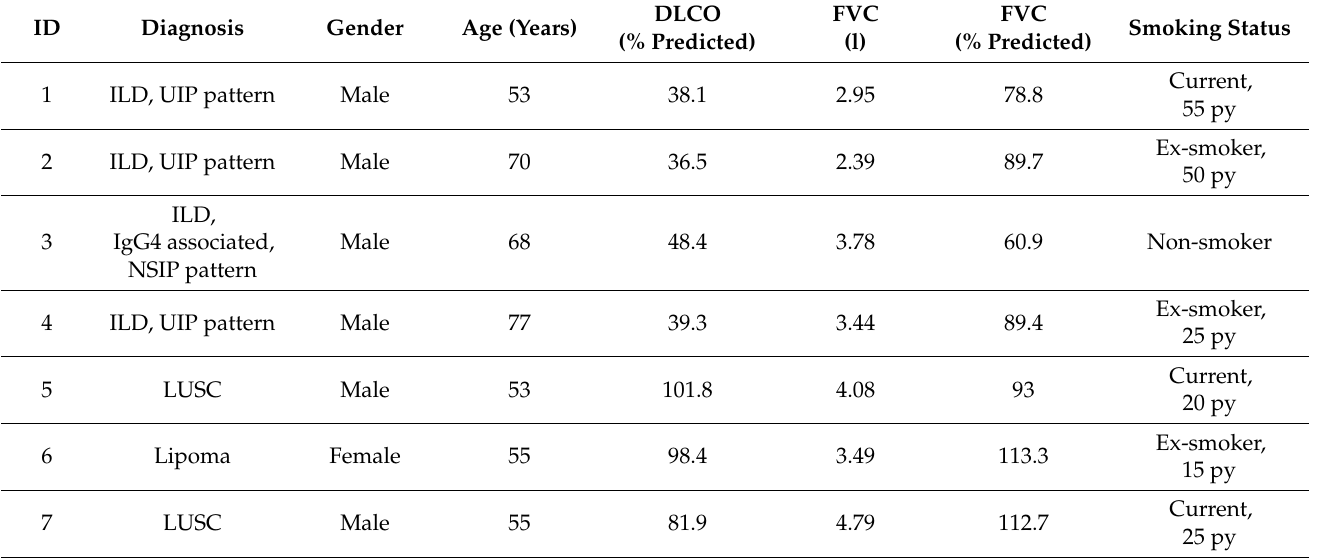
Table 1. Patient characteristics. Age is expressed in years, DLCO (diffuse capacity of the lung for carbon monoxide), FEV 1 (forced expiratory volume in 1 s) and FVC (forced vital capacity, also in total volume) in percentage of the predicted value based on age and gender. Data are expressed as a range (mean ± SD). ILD = interstitial lung disease; UIP = usual interstitial pneumonia; NSIP = nonspecific interstitial pneumonia; LUSC = lung squamous cell